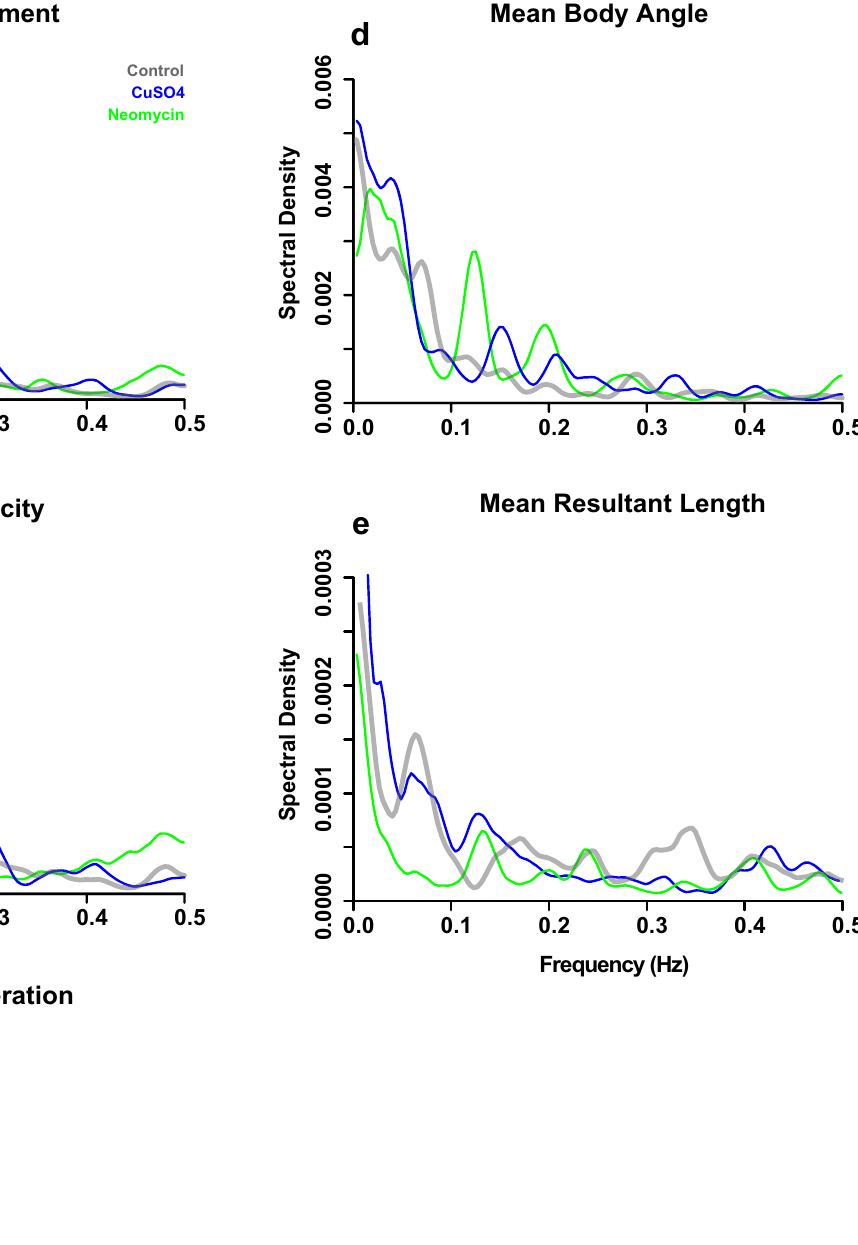
in acceleration (Fig. 9e). However, the strongest correlation between a reduction in angular variance always occurred prior to large changes in relative movement (Fig. 9a), velocity (Fig. 9c), and acceleration (Fig. 9e). In lesioned fi sh, the timing and direction of the strongest cross-correlations shifted the rheotaxis pro fi le of these fi sh away from that of controls in a predictable, consistent, and treatment-speci fi c manner. CuSO 4 -treated fi sh tended to change their mean body angle to the right of